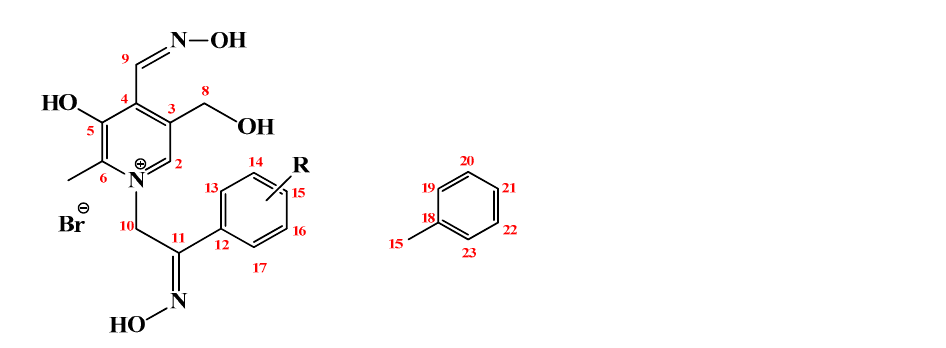
Figure 3. Enumeration scheme for the assignment of the NMR spectra when R = H, F, Cl, Br, NO 2 , OCH 3 , or phenyl.